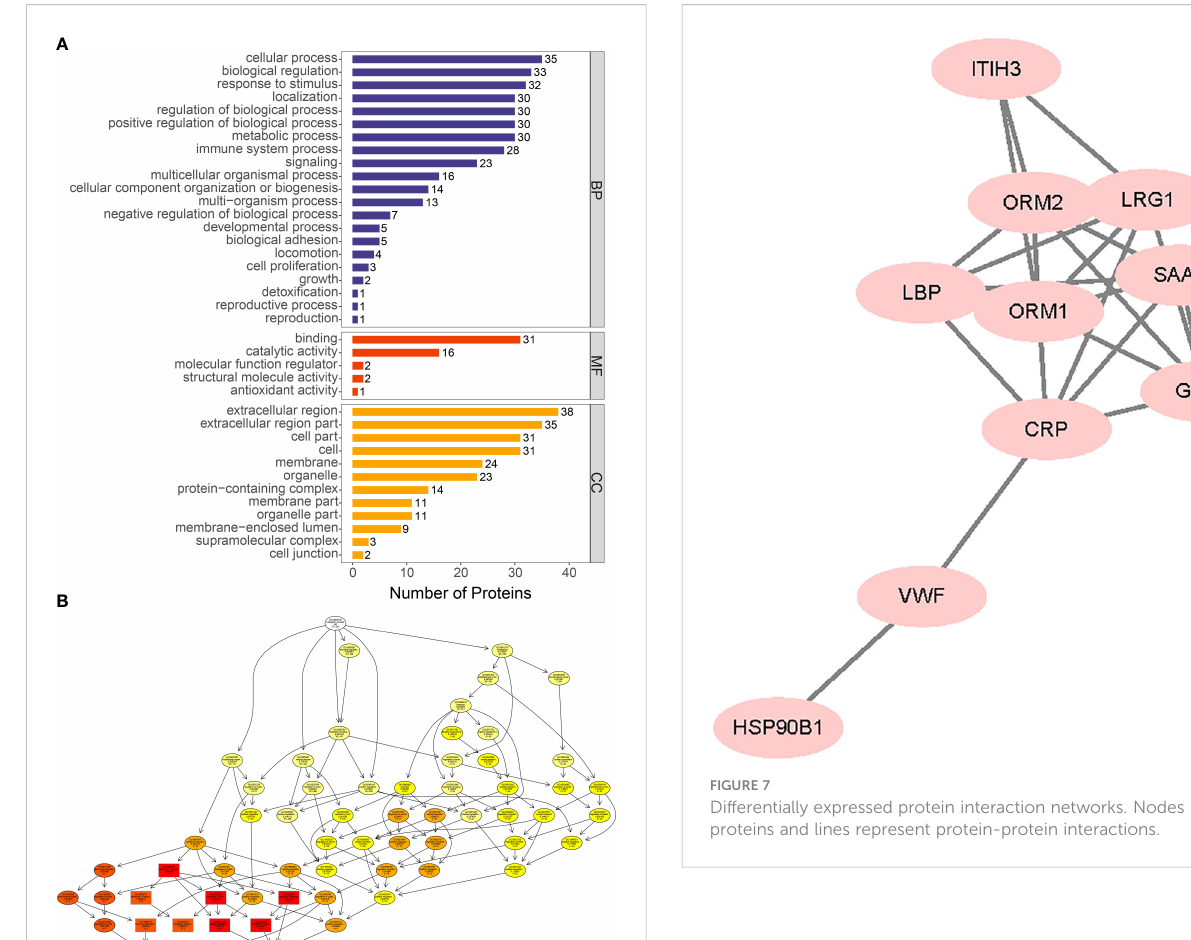
FIGURE 5 GO functional enrichment of differentially proteins. (A) The number of differentially expressed proteins in each categories. The abscissa represents the number of differentially expressed proteins under each functional category. (B) Directed acyclic graph of biological process. The branch represents the containment relationship. The lower the branch is, the more speci fi c the function is.